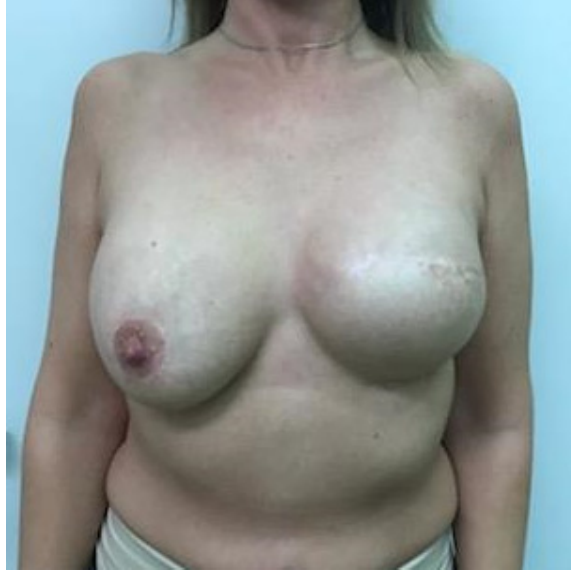
Figure 1. Asymmetry after one year of implant ‐ based IPMBR on the left side and mastopexy and implant symmetrization surgery.